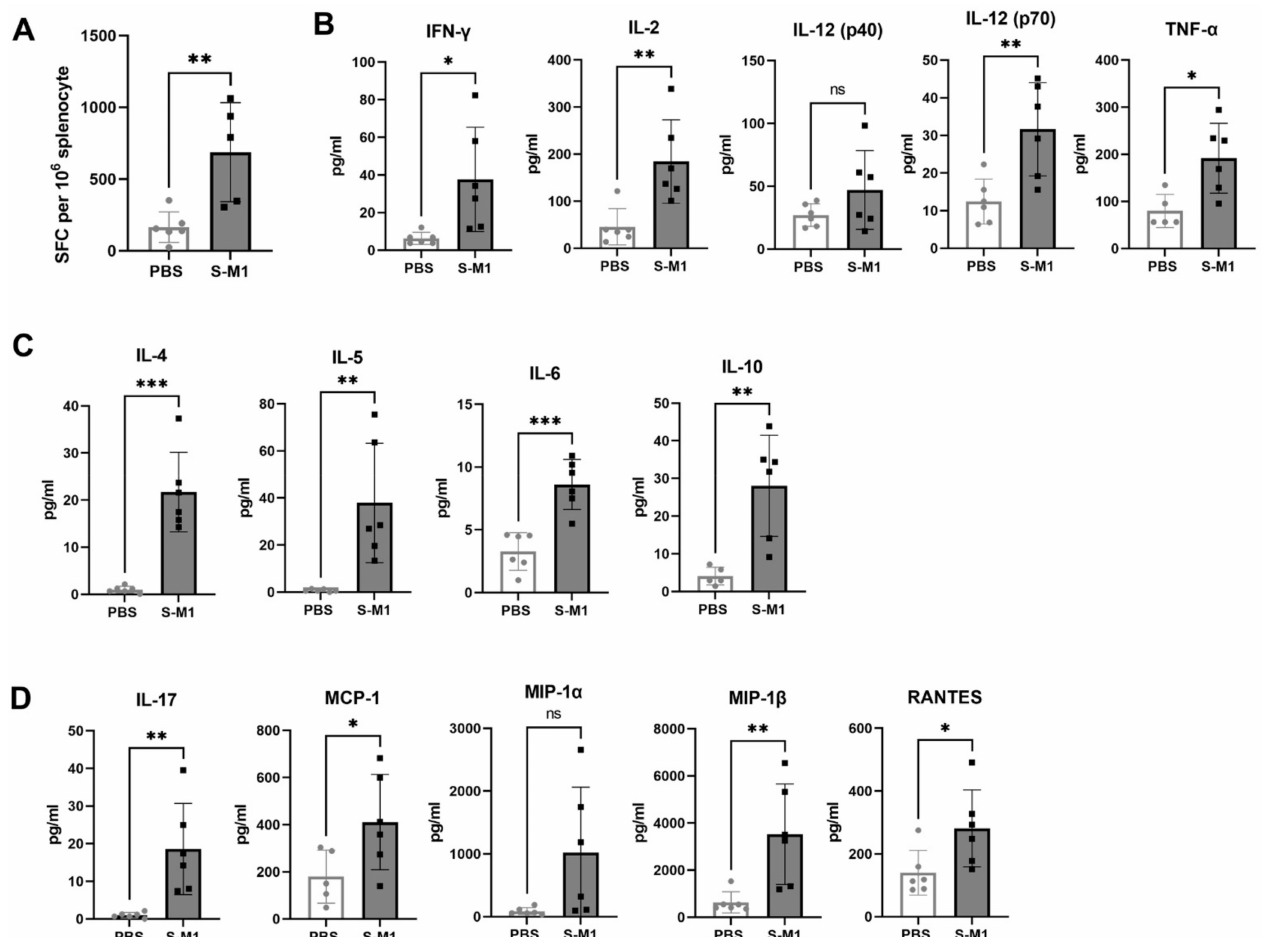
Figure 6. Cellular immune responses to S-M1 VLP vaccination. Splenocytes were isolated from mouse spleens and stimulated with a SARS-CoV-2 peptide pool. ( A ) An ELISpot assay was per- formed to detect IFN- γ -secreting cells and spots were counted using an automated ELISpot reader. ( B – D ) Supernatants from stimulated splenocytes were analyzed for cytokine expression using a magnetic bead-based multiplex assay. Error bars represent means ± sem. ns, no statistical difference; * p < 0.05, ** p < 0.01, *** p <